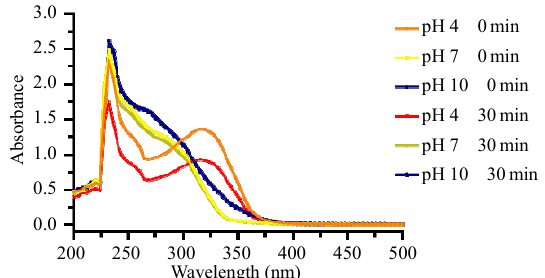
Fig. 2 Absorption spectrum of ThiAKS Green at pH 4.0, 7.0, and 10.0.